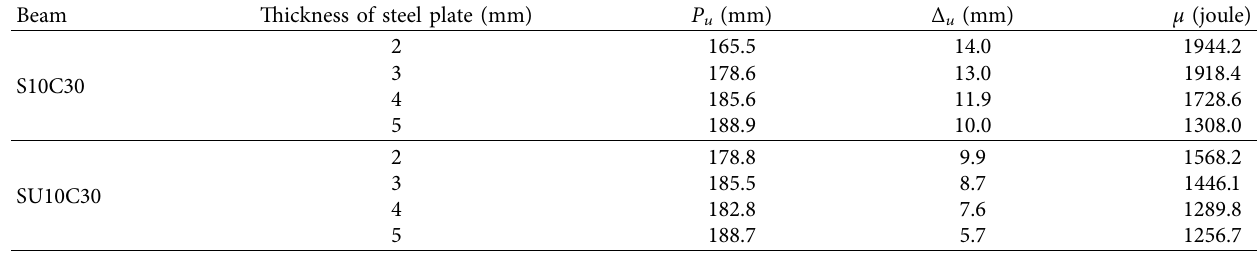
Table 5: Ultimate load, ultimate deflection, and MOTvalue of beams S10C30 and SU10C30 strengthened by the different thicknesses of the steel plate. Beam